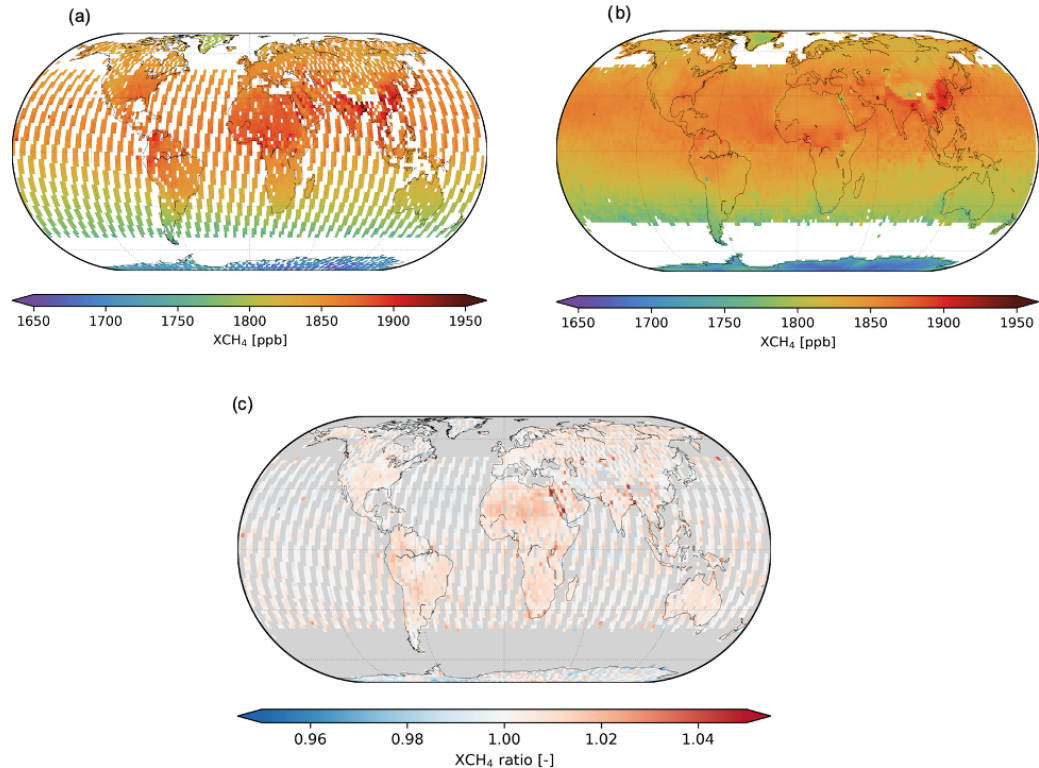
Figure 5. Global distribution of XCH 4 measured by (a ) GOSAT and (b) TROPOMI and (c) the ratio of GOSAT to TROPOMI XCH 4 . Daily collocations are averaged to a 2 ◦ × 2 ◦ grid for the period 1 March 2018–31 December